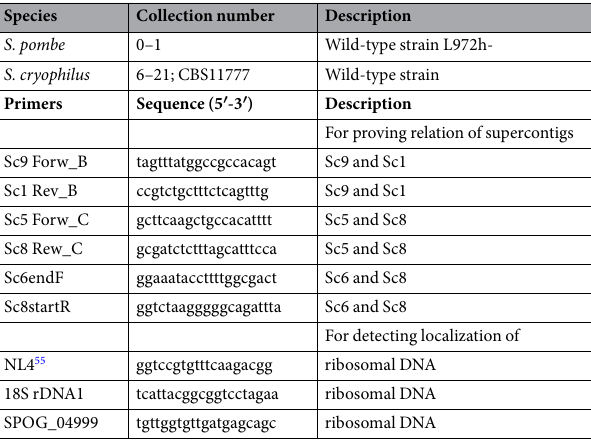
Table 1. List of strains and primers used in this study. Sc: